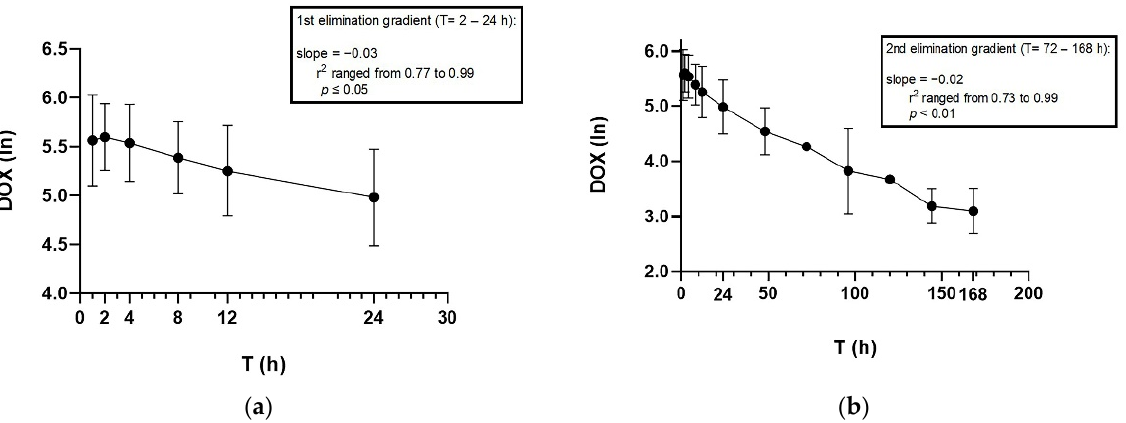
Figure 1. Semi-log graphs showing the mean ± SD of doxycycline plasma concentration when koalas are administered doxycycline 5 mg/kg by the first subcutaneous injection (diluted 50:50 with saline) over ( a ) 24 h and ( b ) 168 h.